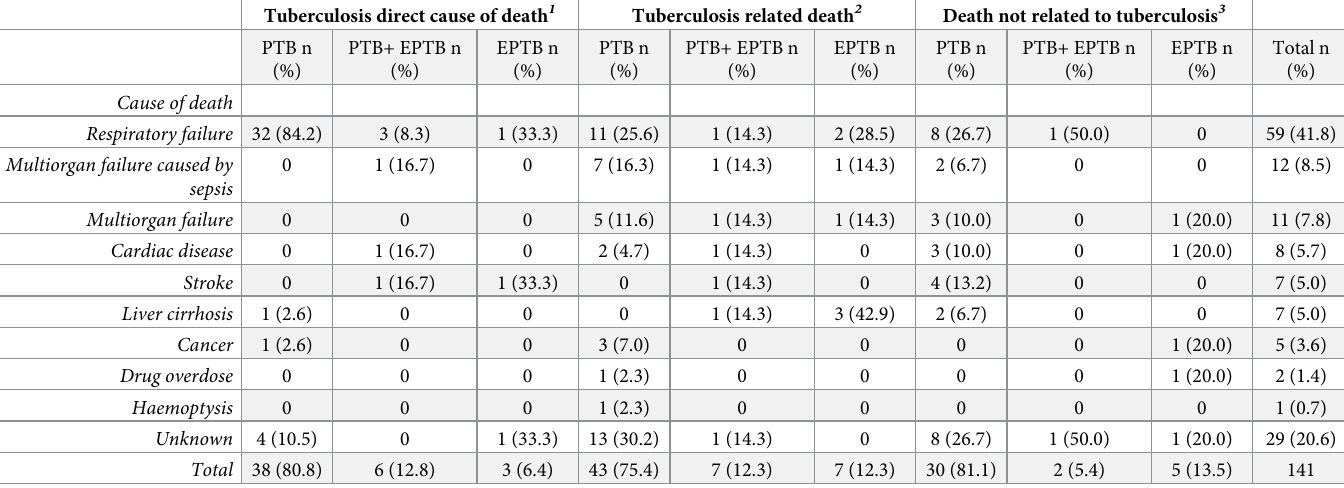
Table 4. Cause of death divided by: TB related death, TB direct cause of death and death not related to TB. Tuberculosis direct cause of death